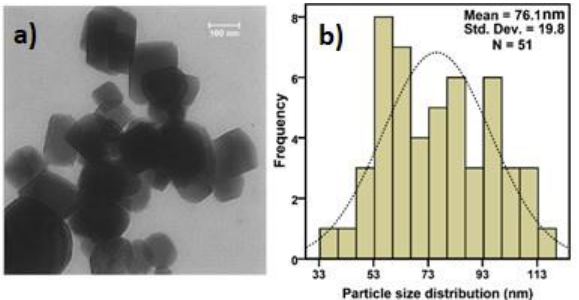
Figure 5. ( a ) TEM image and ( b ) size distribution of MgO NPs.